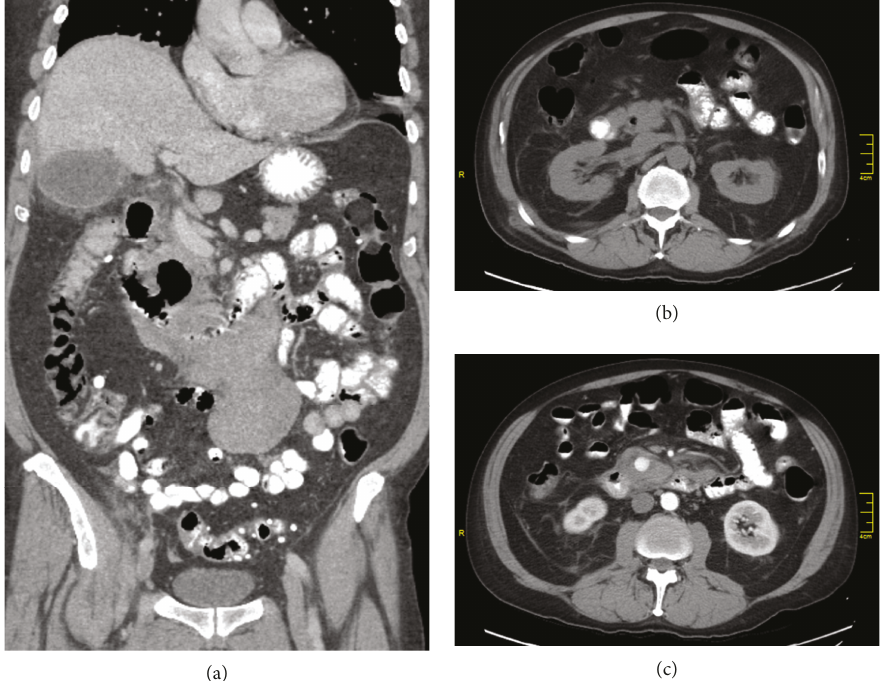
Figure 1: (a – c) CT-scan: (a) large duodenal diverticulum (arrow), mesenteric hematoma, stranding of surrounding tissue. (b) Contrast in diverticulum (arrow). (c) Two cm pseudoaneurysm with hematoma